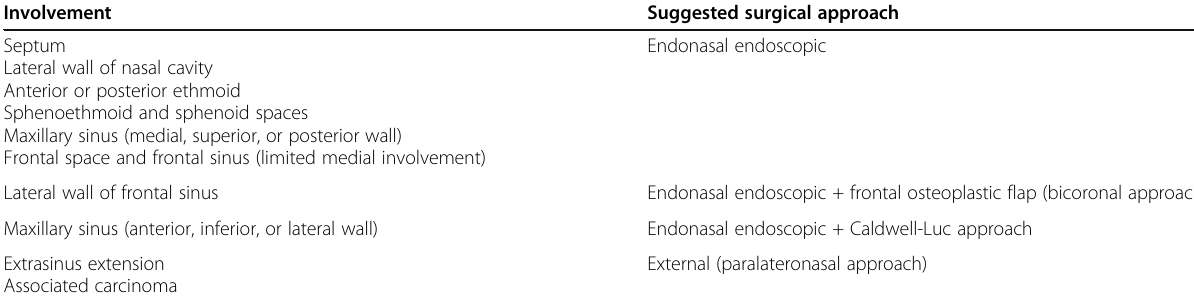
Table 1 Surgical approach according to tumor extension Involvement Suggested surgical approach Septum Lateral wall of nasal